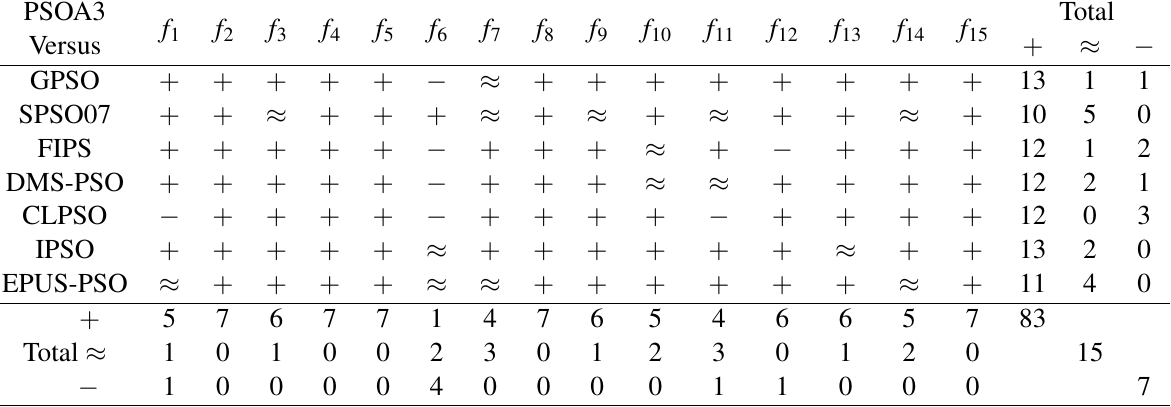
Table 9: Comparisons of success rate(SR)and convergence speed (CS) in successful runs on the 15 functions with 30-D